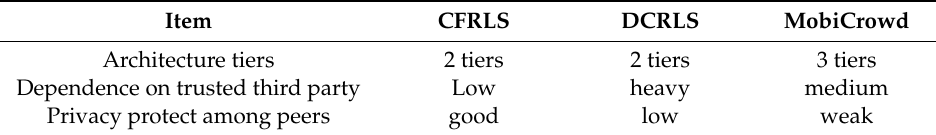
Table 4. The comparison of architectures with different algorithms.